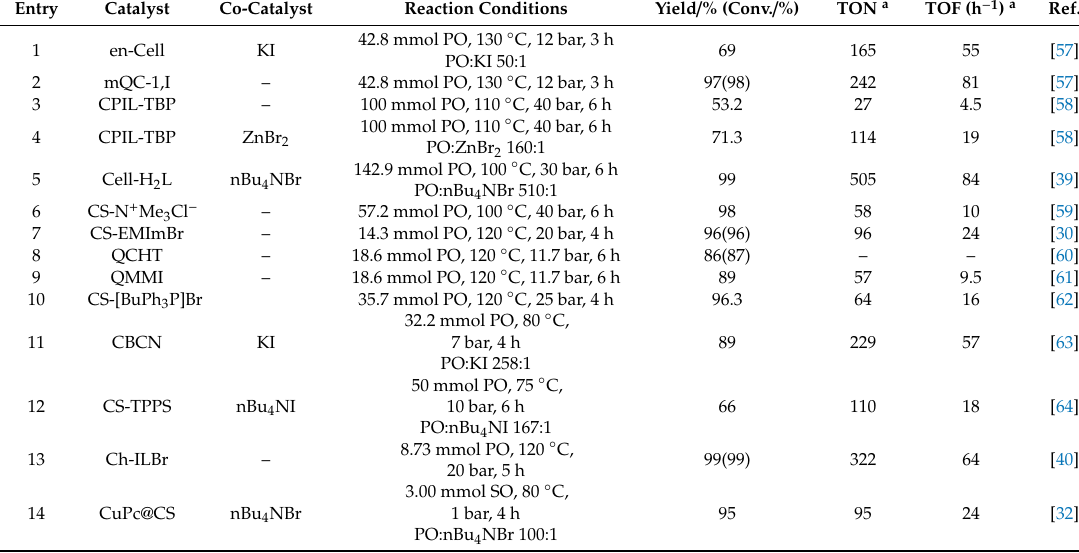
Table 3. Summary of reaction conditions and yields for epoxides conversion to cyclic carbonates using functionalized biomass-based catalysts (propylene oxide (PO) and styrene oxide (SO)). Catalyst Reaction Conditions Yield / % (Conv. /